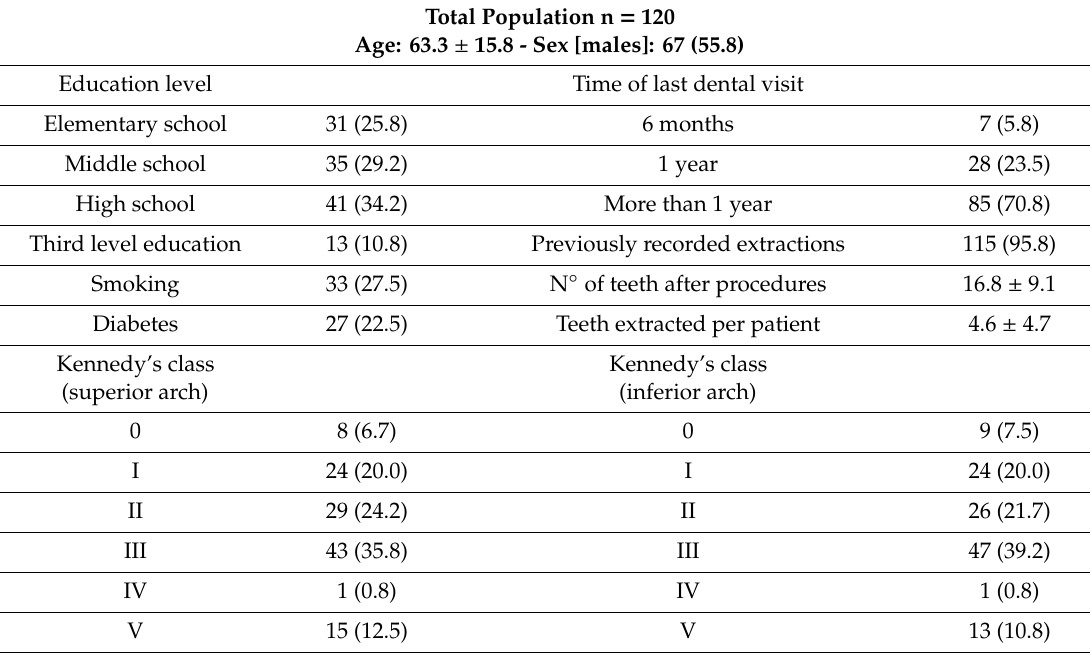
Table 1. The demographic and clinical features of the study